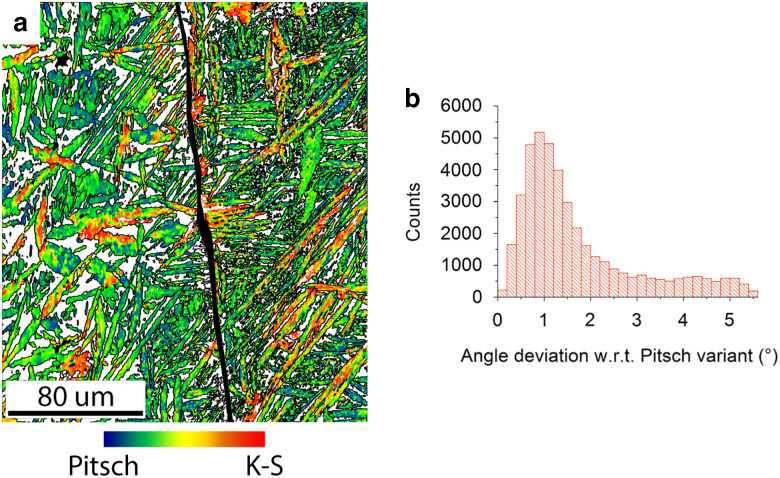
Distribution of Pitsch to Kurdjumov–Sachs (K–S) orientation relationship (OR) continuum through the sample. a: The orientation map of the FCC grains shows which areas have a Pitsch orientation (blue), which areas have a K–S orientation (red), and which areas have an orientation between a Pitsch and K–S orientation with respect to the average orientation of their parent BCC grain. The grain boundary between the two BCC grains has been highlighted (black). b: The misorientation distribution with respect to the nearest theoretical Pitsch variant. The theoretical K–S variants have a 5.26° misorientation with respect to the nearest Pitsch variant. The misorientation peak is found at 0.88°.